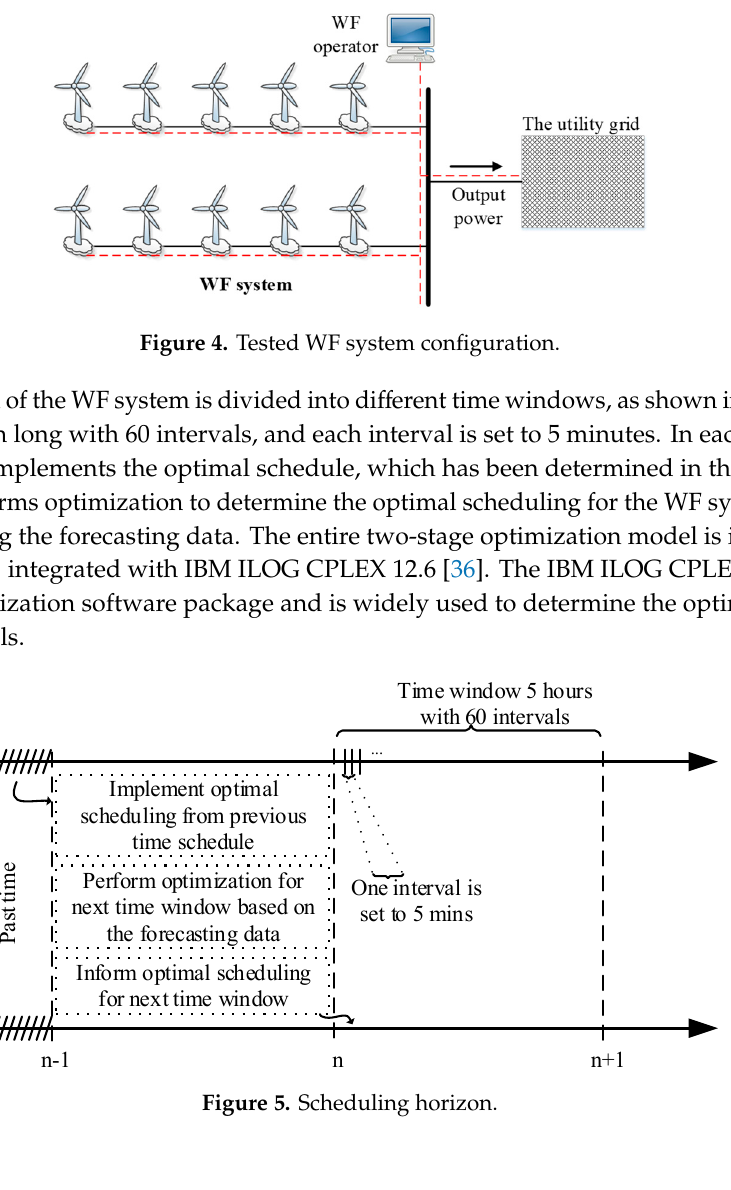
Figure 5. Scheduling horizon.